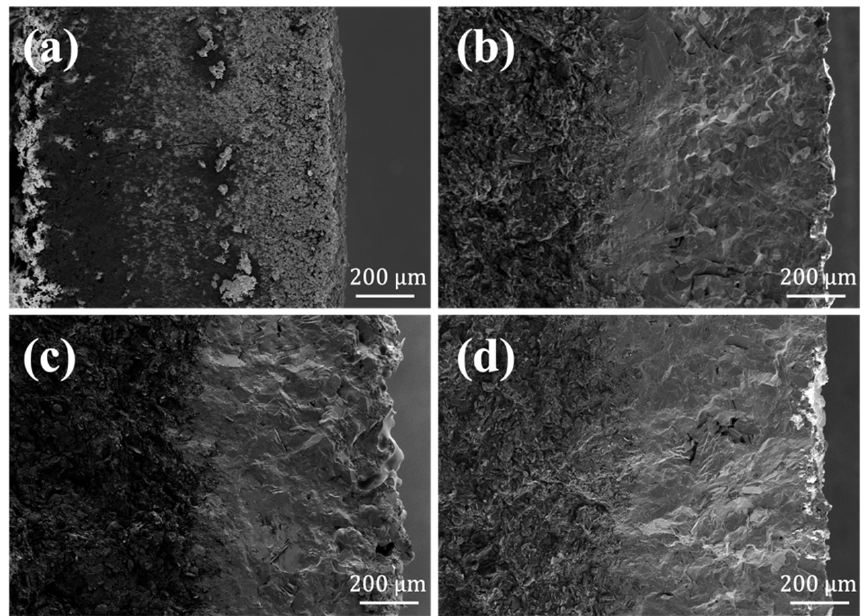
Figure 6. SEM images of the cross-section of SiC/MoSi 2 -SiC-Si coatings after oxidation with different Si/Mo ratio: ( a ) 1:1, ( b ) 3:1, ( c ) 5:1, ( d ) 7:1.